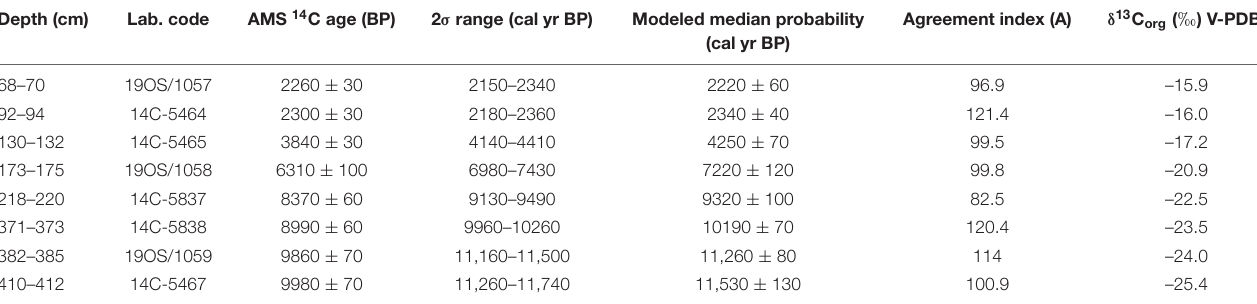
TABLE 1 | Radiocarbon analysis of bulk organic matter in sediments, calibrated results, and modeled ages used for the Bayesian age-depth model of a core from southwestern margin of Lake Coatetelco (central Mesoamerica) in OxCal version 4.4 ( P sequence, k = 0.05 and A model = 112.2). Depth (cm) Lab.